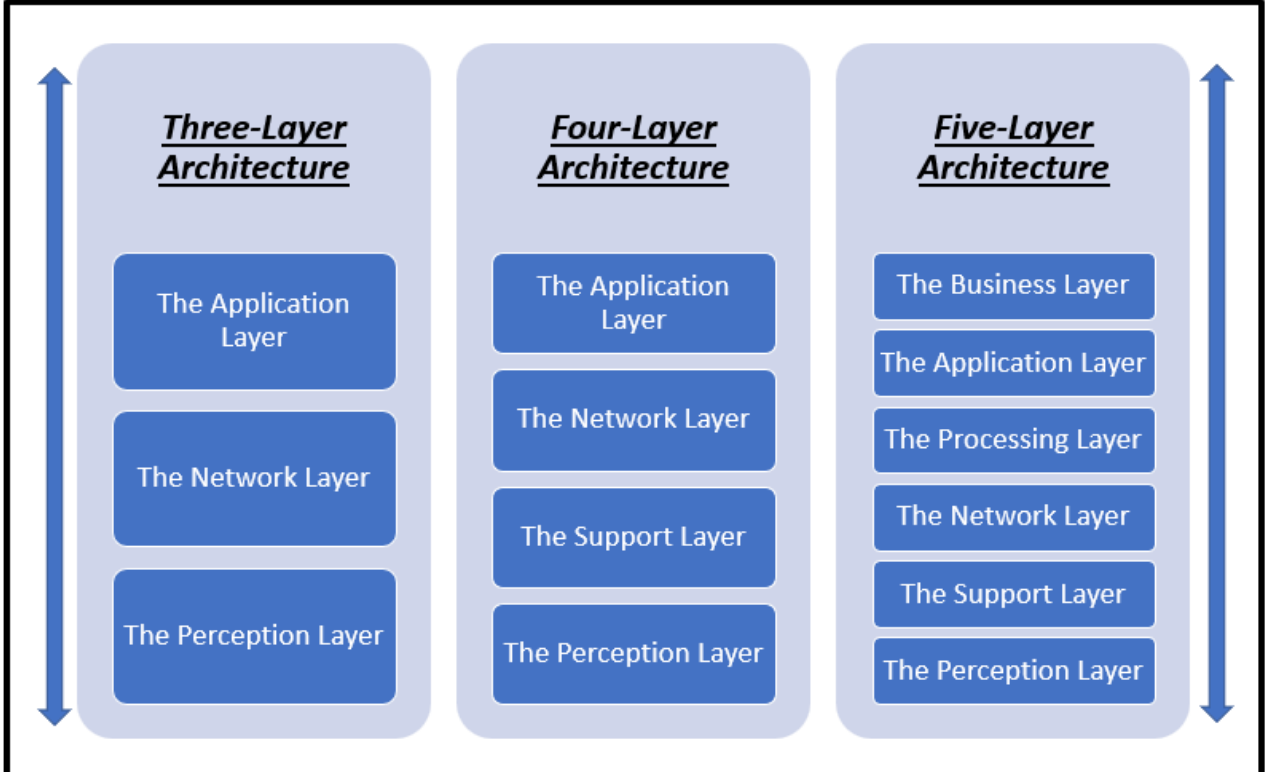
Figure 1. Comparison between 3, 4, and 5 layers of IoT architectures. (1) Three-Layer Architecture